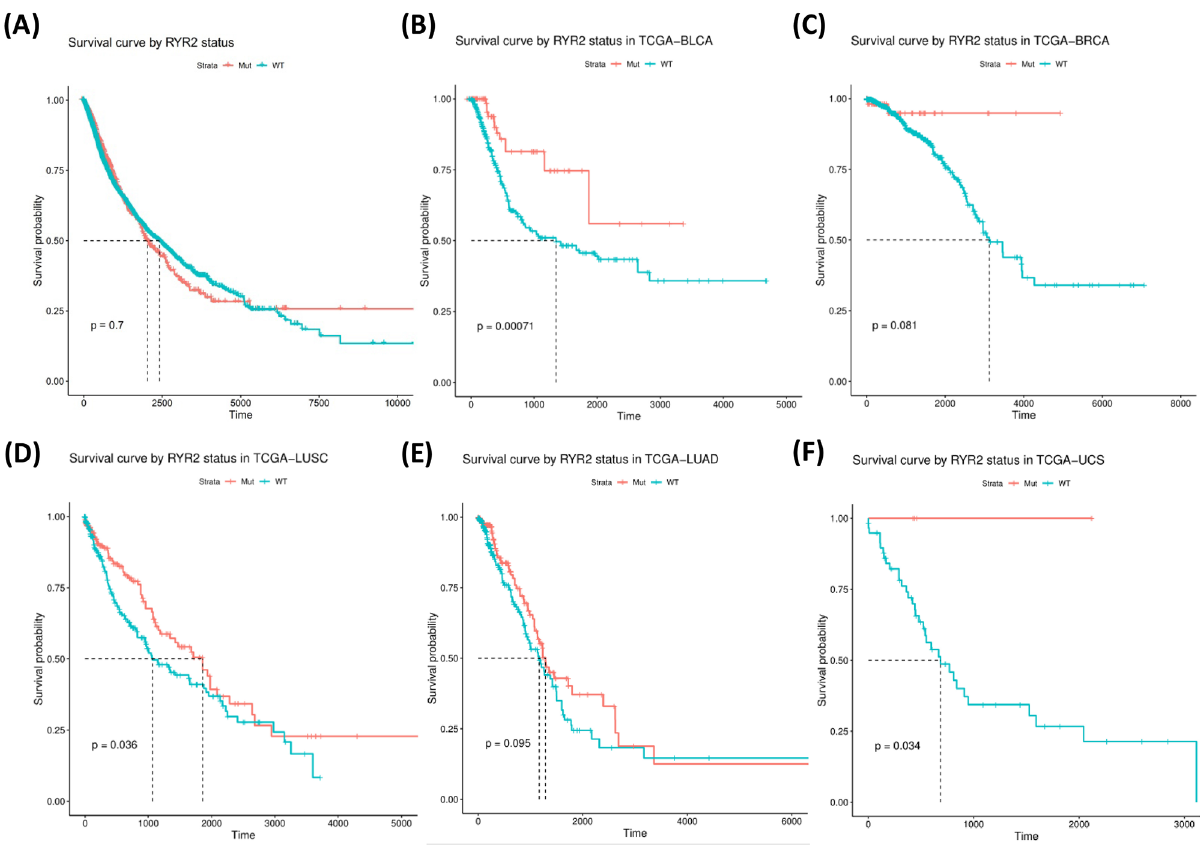
Figure 8. Kaplan–Meier survival analysis based on RYR2 mutational status (mutant or WT). The data for overall survival (OS) time is shown for each subgroup. ( A ) The survival analysis based on RYR2 mutational status for all types of cancers. ( B – F ) The survival analysis based on RYR2 mutational status for each type of cancer, as indicated. Only cancer types with P ≤ 0.1 are shown. P values are indicated in each panel. The unit for time is